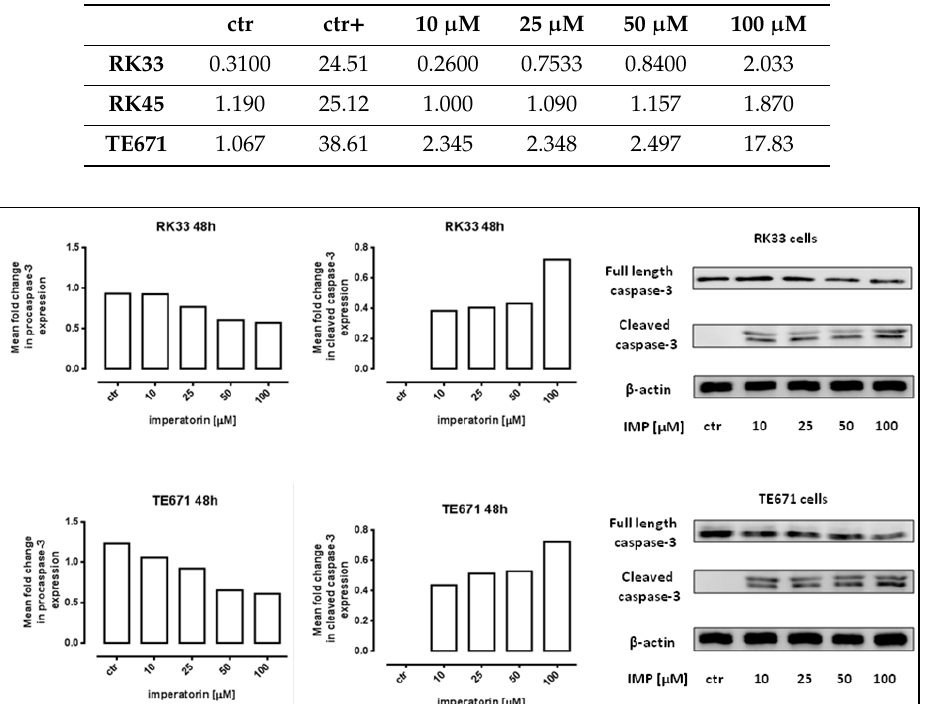
Table 1. The percentage of cancer cells positive for active caspase-3 when treated with IMP for 48 h.